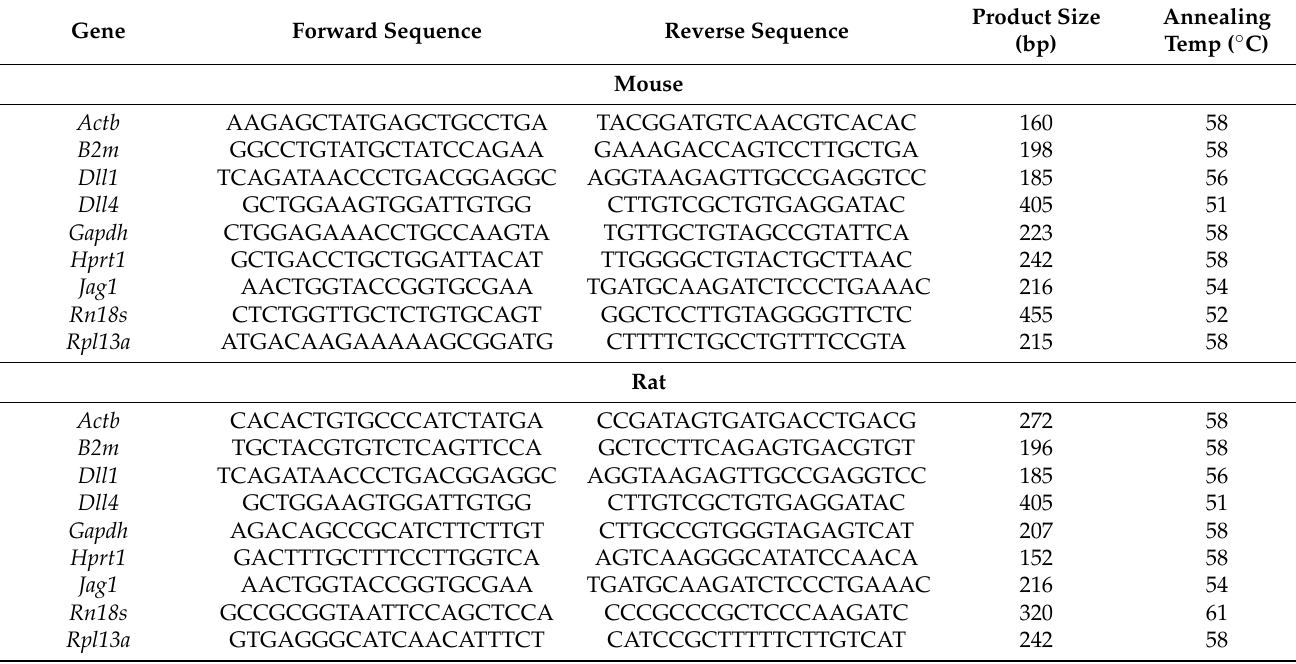
Table 1. Sequences of forward and reverse